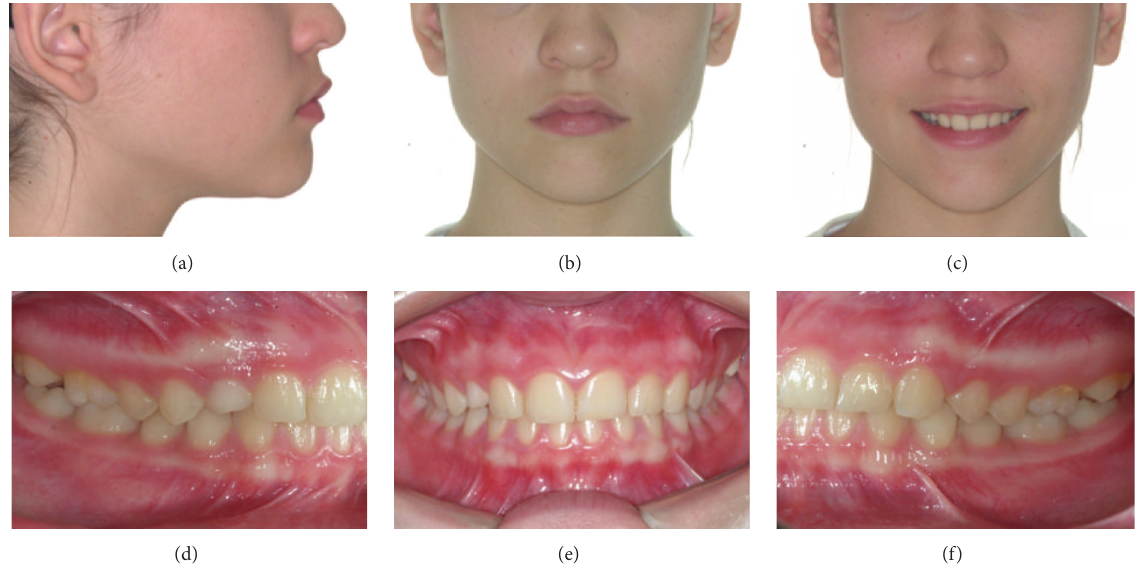
Figure 1: Initial documentation: profile photo (a); frontal photo (b); frontal photo with smile (c); intraoral photos: right, (d) frontal (e), and left side (f).